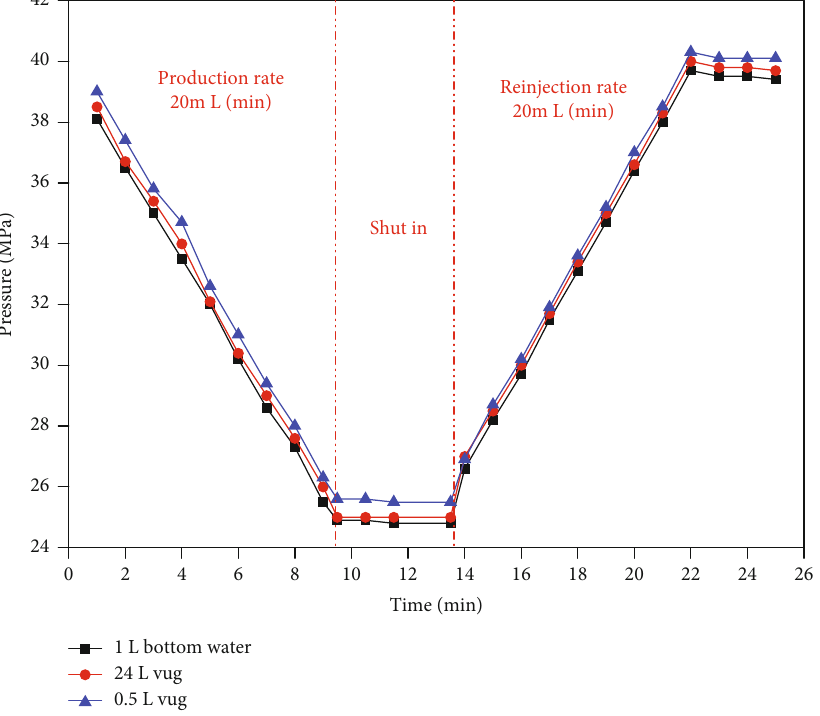
Figure 7: Pressure variation curves of reinjection in high-pressure physical property experiments under connection type I ( production rate andreinjection rate = 20